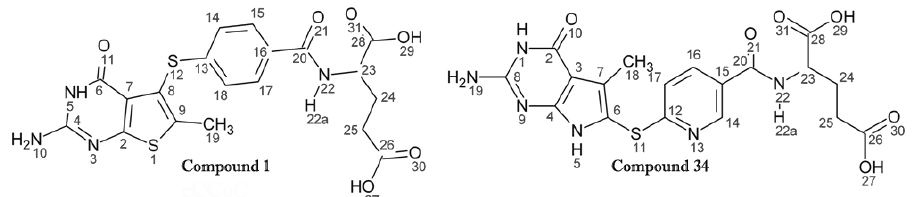
Figure 6. Showing change in the position of S12 to S11 from molecule 1 to molecule 34.